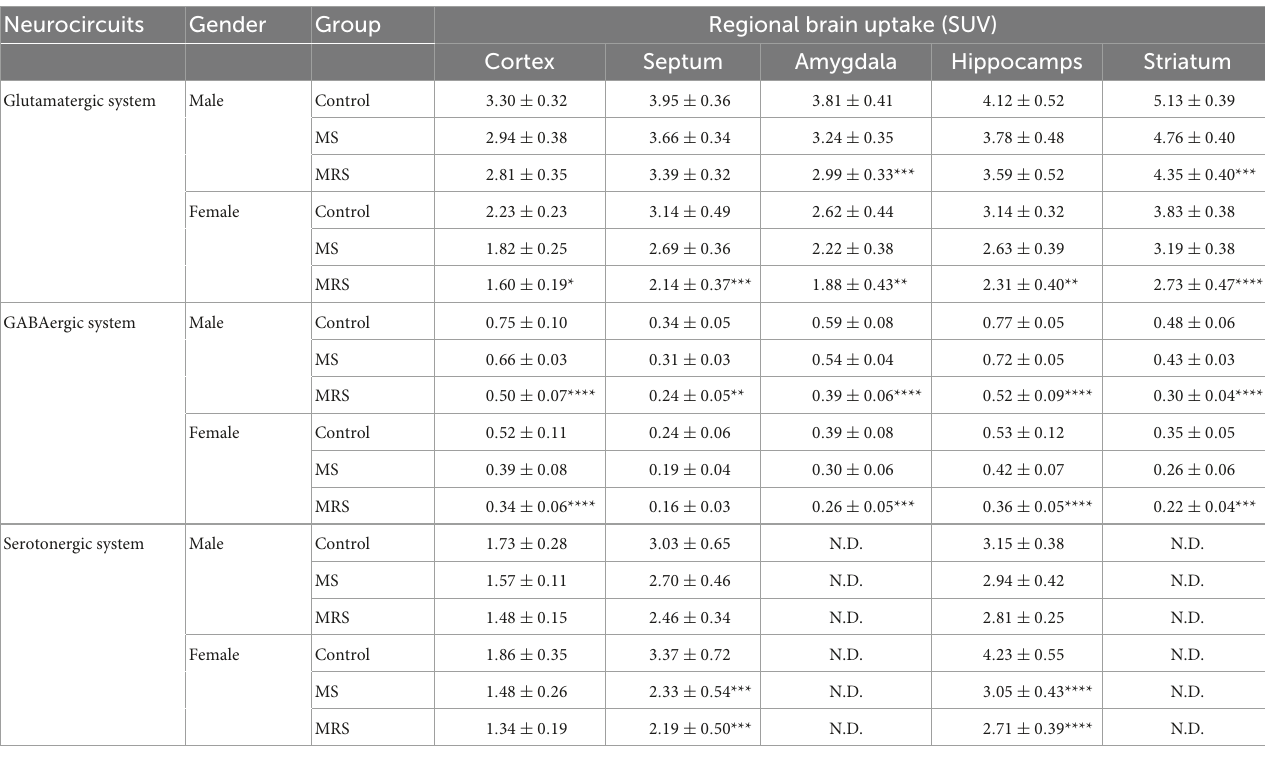
TABLE 1 Comparison of the regional brain uptake values